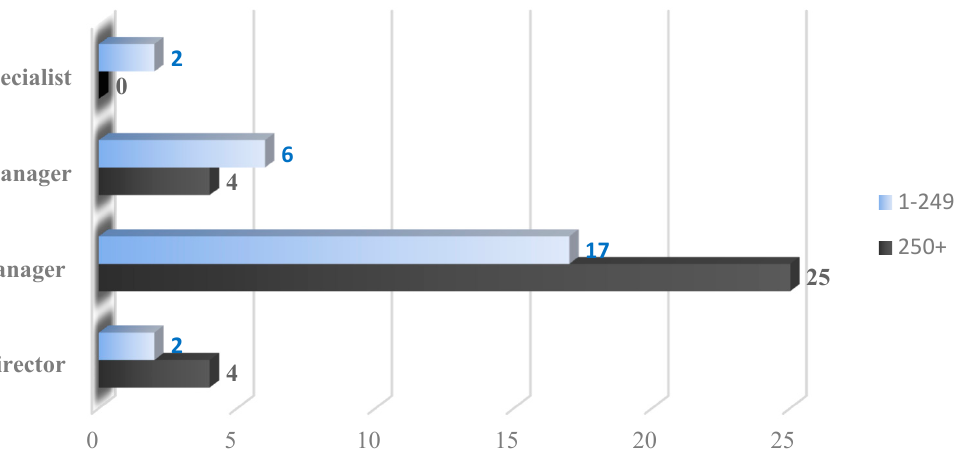
Figure 1. Division of respondents according to their position.